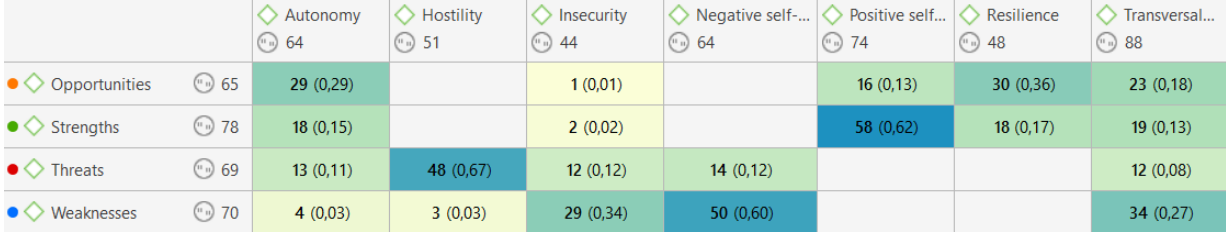
Figure 3. Co-occurrence coefficients between SWOT dimensions and emerged categories.